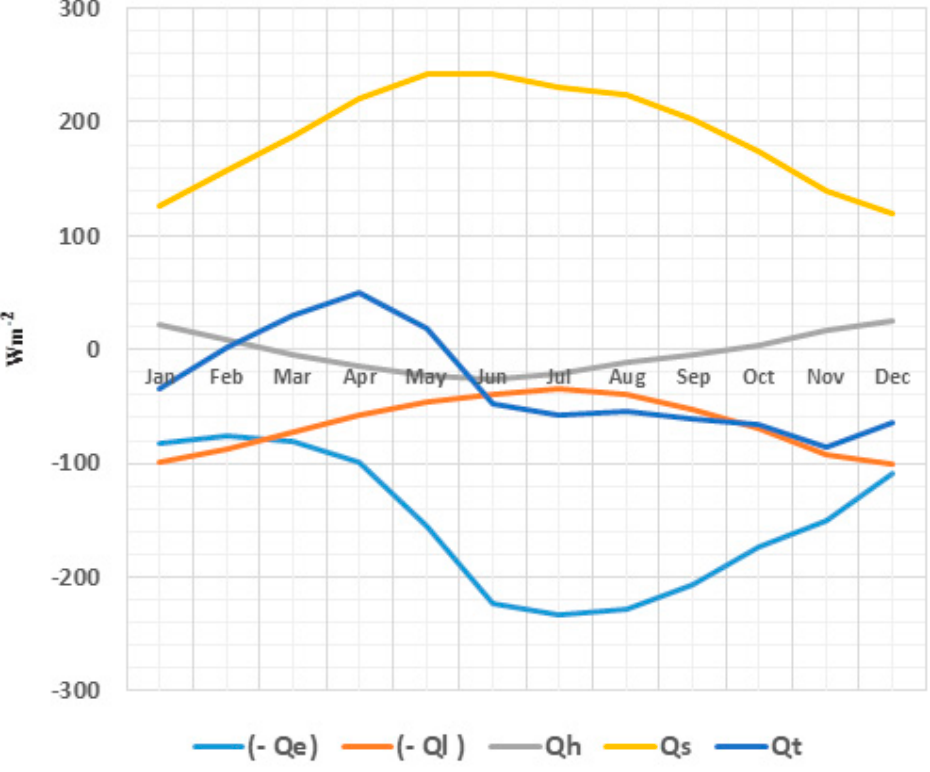
Figure 9. The annual cycle of heat flux (Wm − 2 ) at the surface of the Arabian Gulf. Table 3. Monthly average values for Qe, Ql, Qh, Qs, and Qt in Wm − 2